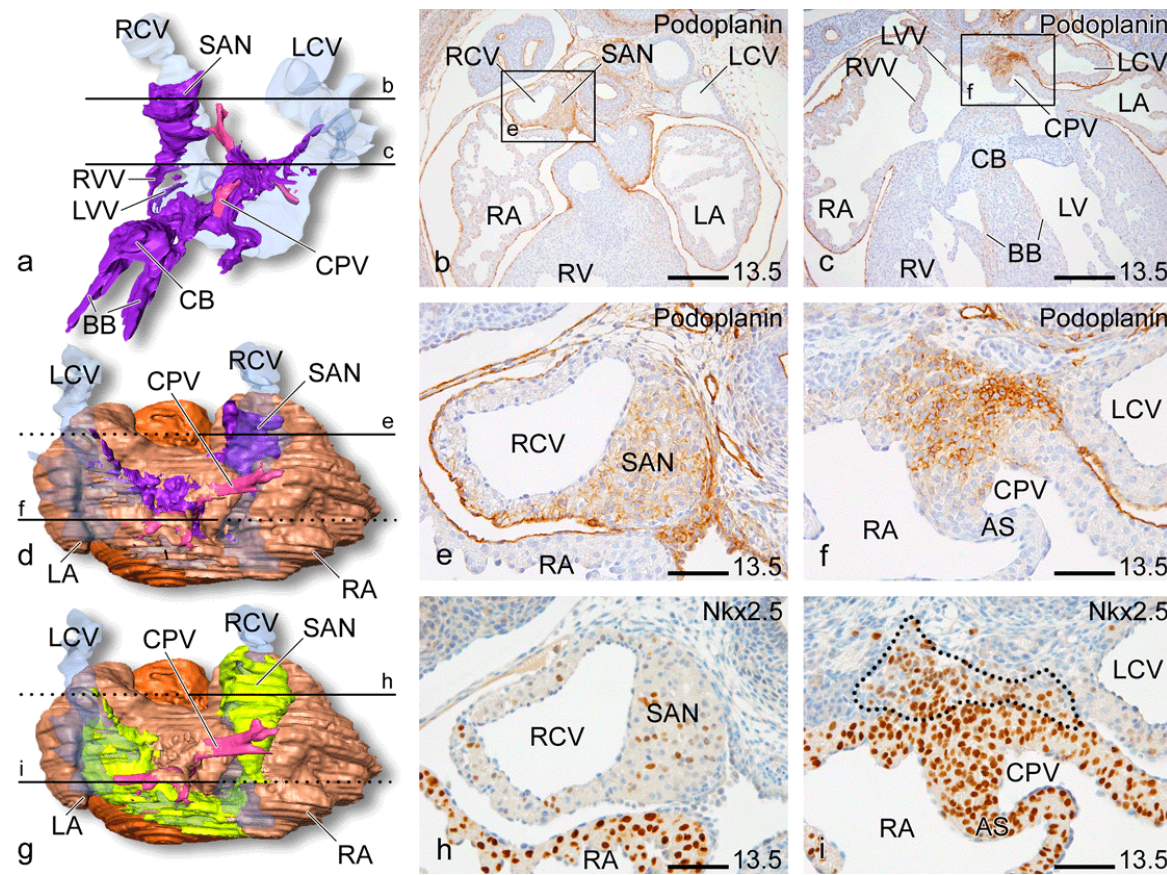
FIGURE 5. Three-dimensional (3-D) reconstructions (a, d, g, for color codes see below) and transverse sections (b, c, e, f, h, i) of an E13.5 wild- type (WT) mouse heart demonstrating podoplanin and Nkx2.5 expression. a: Ventral view of a reconstruction giving an overview of podoplanin expression in various parts of the CCS myocardium. Line b indicates podoplanin expression in the sinoatrial node region (SAN) and line c indicates podoplanin staining around the common pulmonary vein (CPV) corresponding to sections b and c, respectively (for details see e and f). Podoplanin expression is indicated in the SAN, right (RVV) and left (LVV) venous valves, the atrioventricular nodal region (AVN), common bundle (CB) and bundle branches (BB). d and g: dorsal view of reconstructions showing, respectively, podoplanin-positive (purple) and Nkx2.5- negative (lime green) areas at the sinus venosus region of the embryonic heart. Line e demonstrates a dorsal view of podoplanin expression at the SAN and line f demonstrates a dorsal view of podoplanin expression around the CPV, indicated in sections e and f, respectively (boxed area in b and c). Lines h and i indicate similar regions as lines e and f showing Nkx2.5-negative areas of the SAN (section h) and around the CPV (marked area in section i). The podoplanin-positive area of the sinus venosus region corresponds with the more extensive Nkx2.5-negative (mosaic) area (compare d with g). AS: atrial septum, LA: left atrium, LCV: left cardinal vein, LV: left ventricle, RA: right atrium, RCV: right cardinal vein, and RV: right ventricle. Color codes — light brown: myocardium of the atria, dark brown: myocardium of the ventricles, transparent blue: cardinal veins, pink: pulmonary veins, purple: podoplanin-positive myocardium, and lime green: Nkx2.5-negative (mosaic) myocardium. Scale bars — b and c: 200 μ m; e, f, h, and i: 100 μ